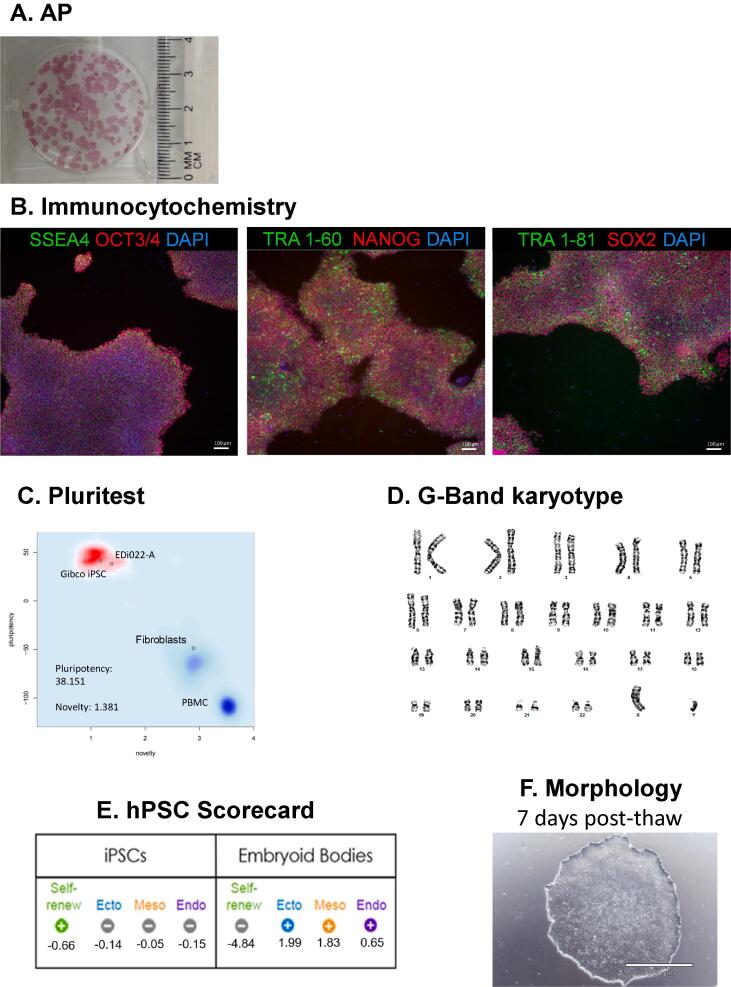
Characterization for iPSC line EDi021-A.